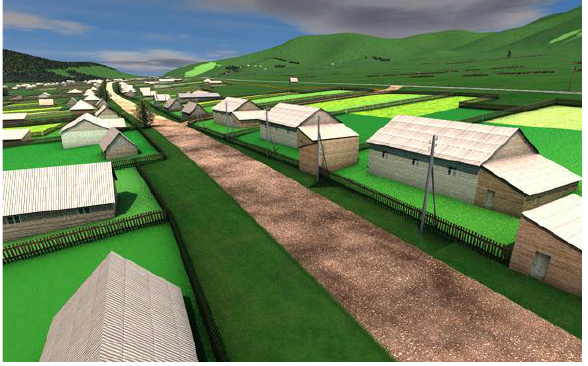
Figure 4: Tuekta in a rendered 3D